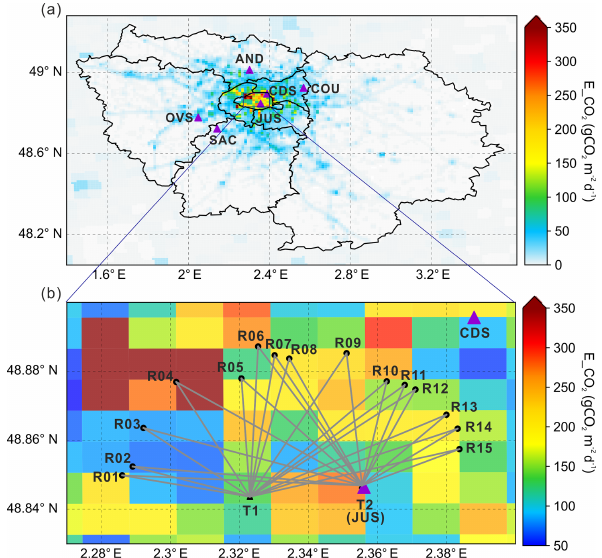
Figure 2. Total CO 2 emissions, according to the AIRPARIF inven- tory (within IdF) and the IER inventory (outside IdF), for a weekday in March 2016. Panel (a) shows the CO 2 emissions over the IdF re- gion together with the in situ measurement stations. Panel (b) is a high-resolution zoom of the inner Paris area and shows the 1km emissions together with the GreenLITE ™ chords and two urban in situ measurement